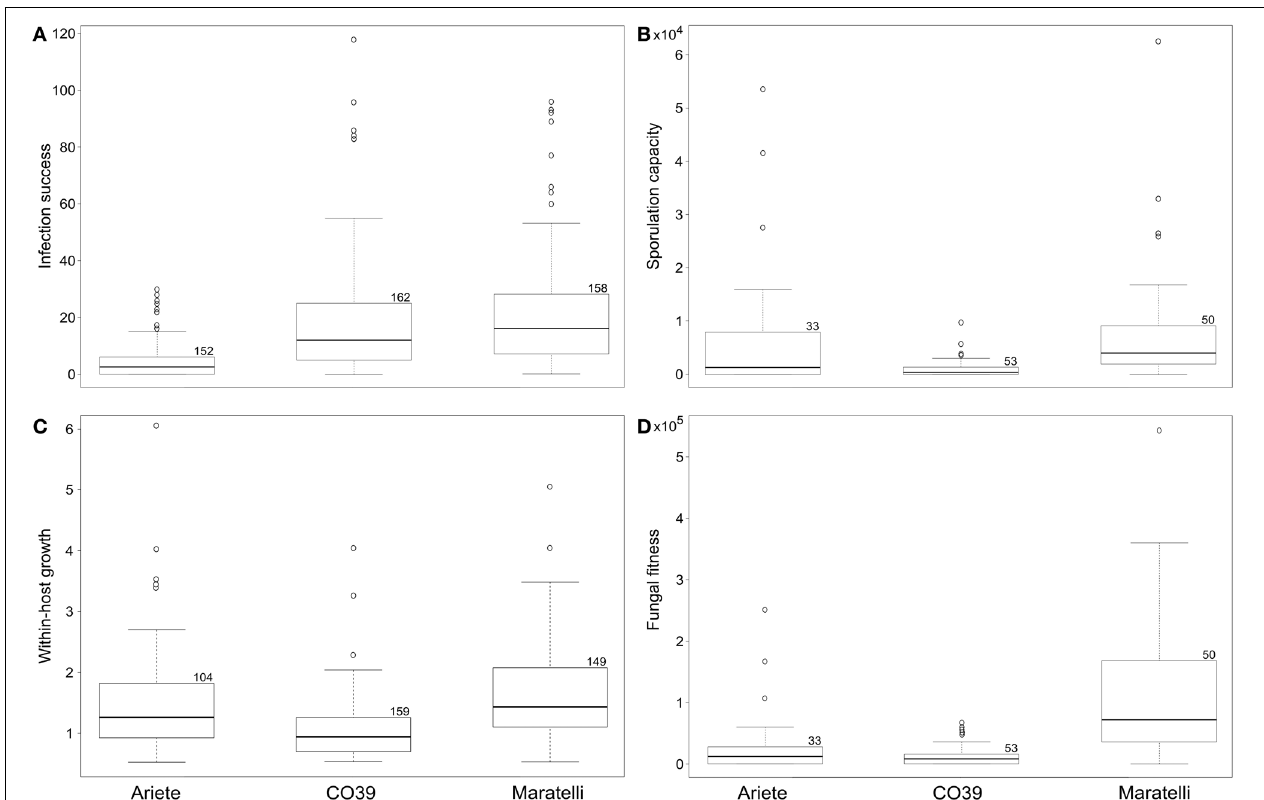
FIGURE 1 | Boxplots depicting rice varieties performance, for (A) the number of lesions, (B) the number of spores per lesion, (C) the lesion size, and (D) the number of spores per plant (our measure of fitness). The box limits represent the upper and lower quartiles, the bold line represents the median, and the whiskers the minimum and